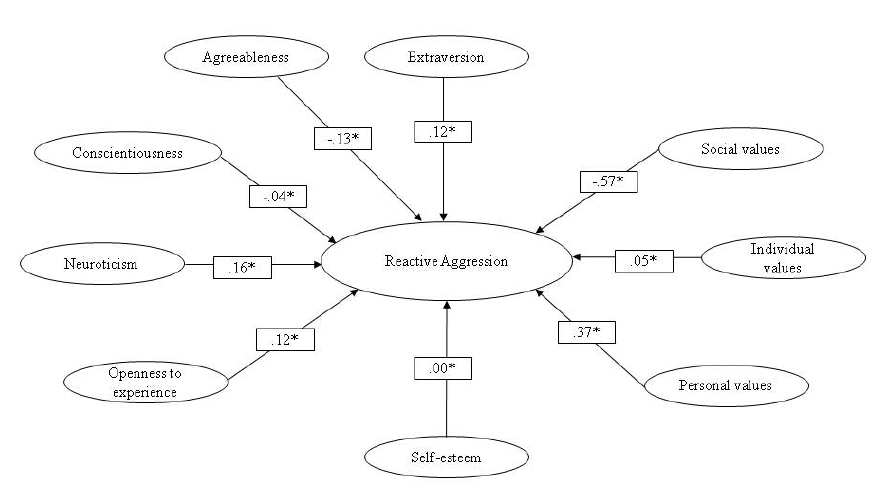
Figure 3. Structural equation model for reactive aggression (non-involvement) using personality, values, and self-esteem